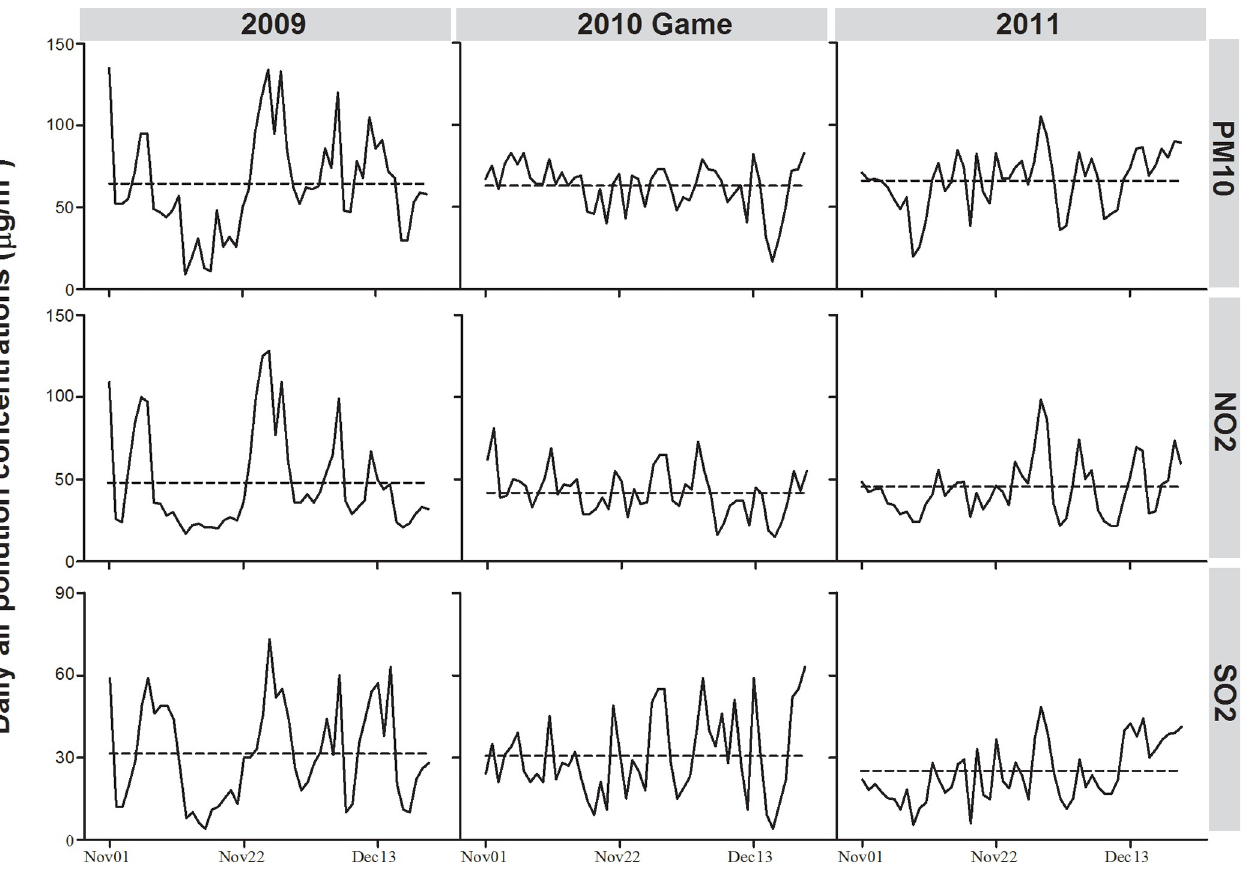
Fig 2. Time series of daily air pollution concentrations during the 2010 Asian Games period and during the baseline years in Guangzhou.